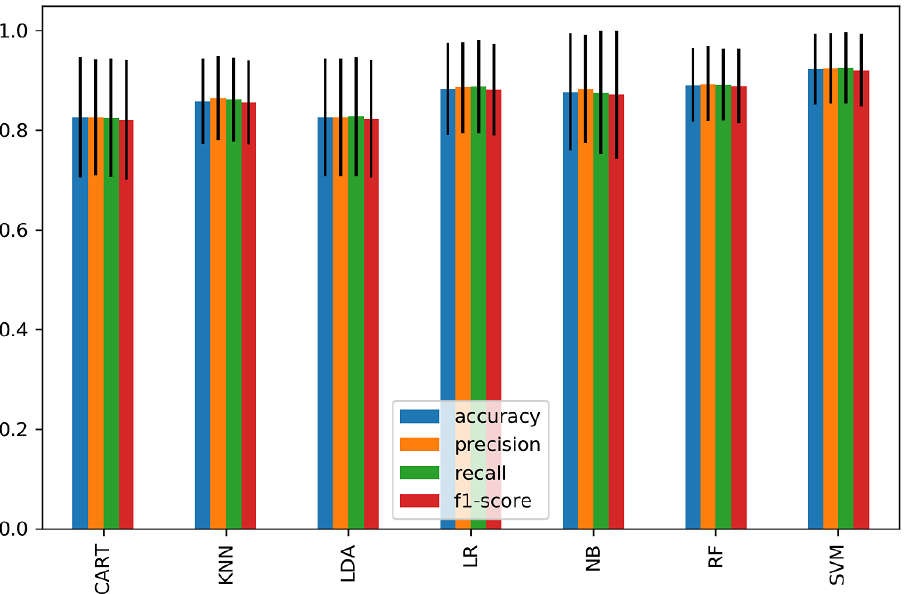
Figure 11. The average classification performance and standard deviation of hybrid features consist- ing of 42 significant features from the time domain, frequency domain, and connectivity